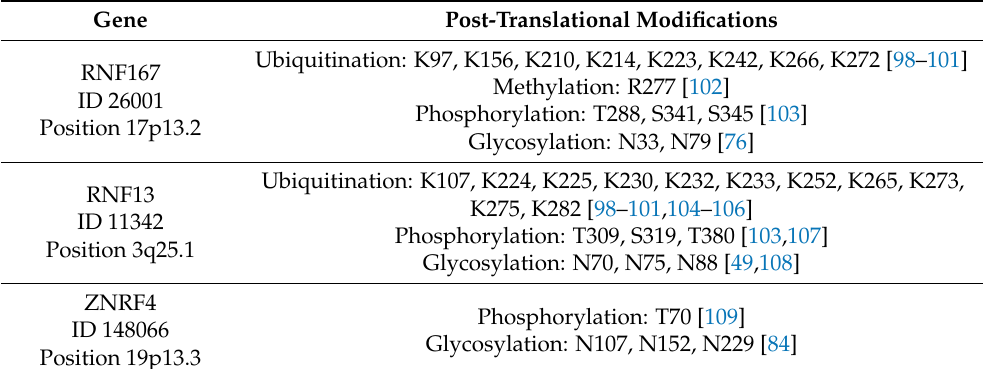
Table 2. Information on gene and post-translational modifications of human homologues of Godzilla.